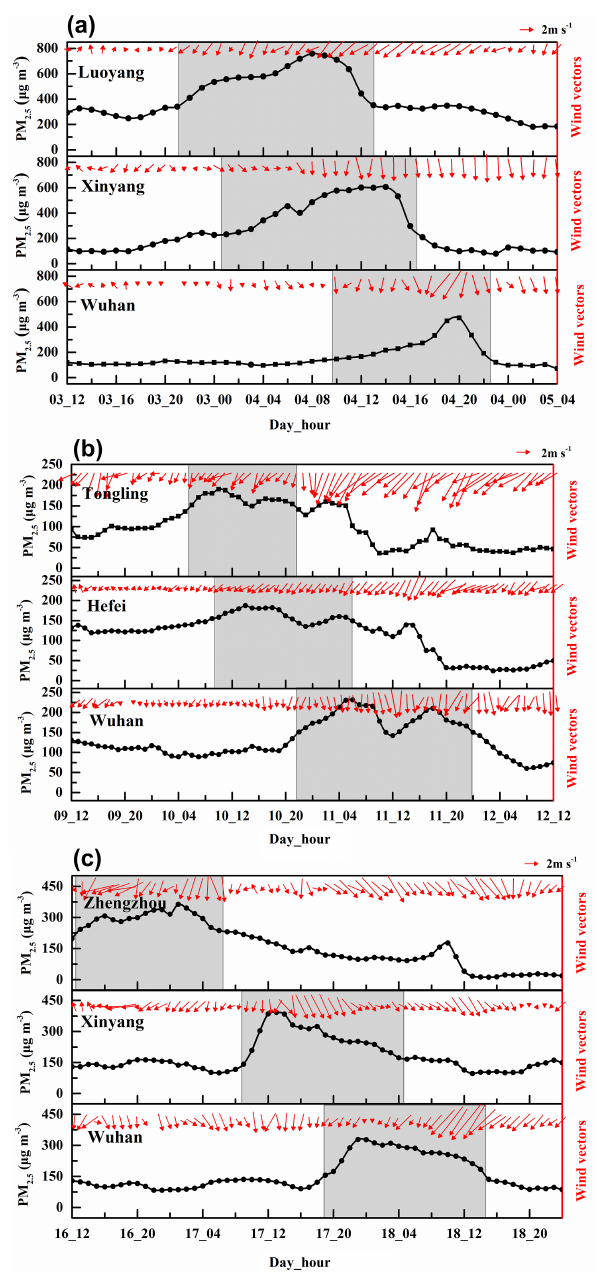
Figure 8. Temporal changes in PM 2 . 5 concentrations (dotted lines) and near-surface winds (vectors) observed at five upstream sites (Fig. 6) and Wuhan with shifts in PM 2 . 5 peaks (marked with shaded areas) to the YRMB’s heavy PM 2 . 5 pollution periods P1 ( a ), P2 ( b ) and P3 ( c ), in January 2016.